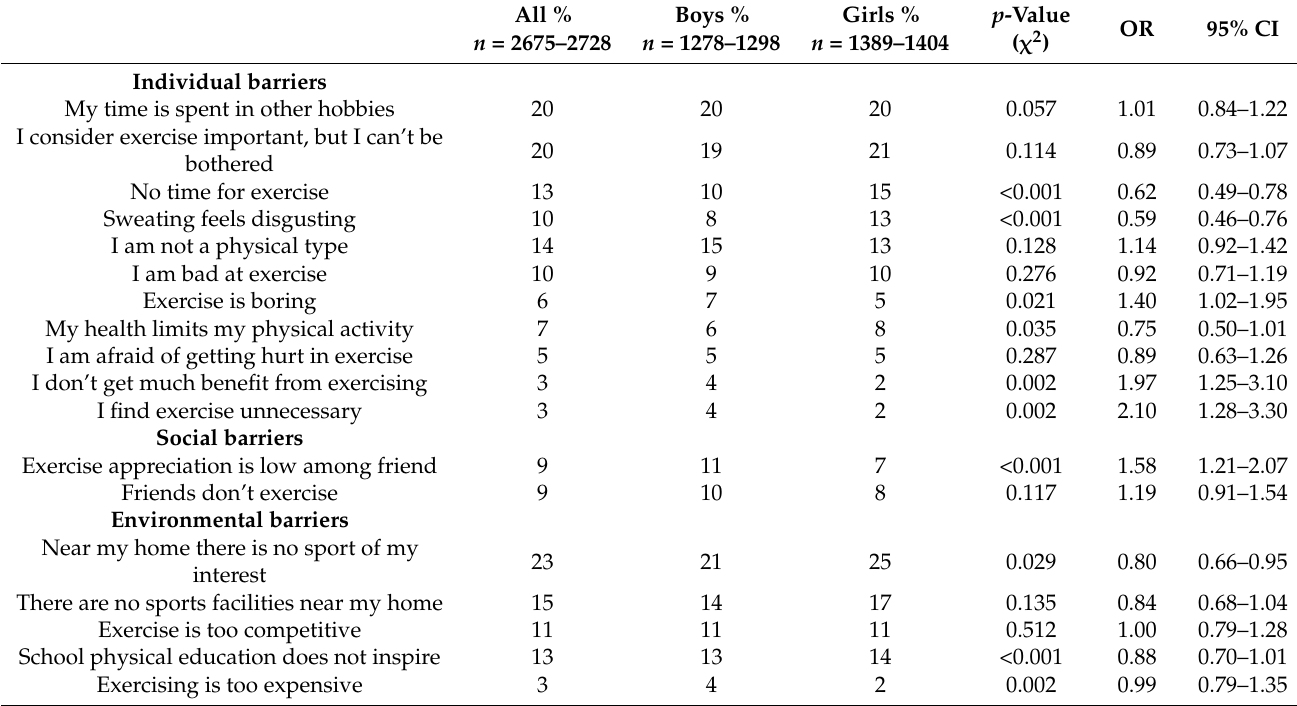
Table 2. Girls’ and boys’ barriers of physical activity (the claim holds at least somewhat) (%, p -value χ 2 , effect size OR, 95%